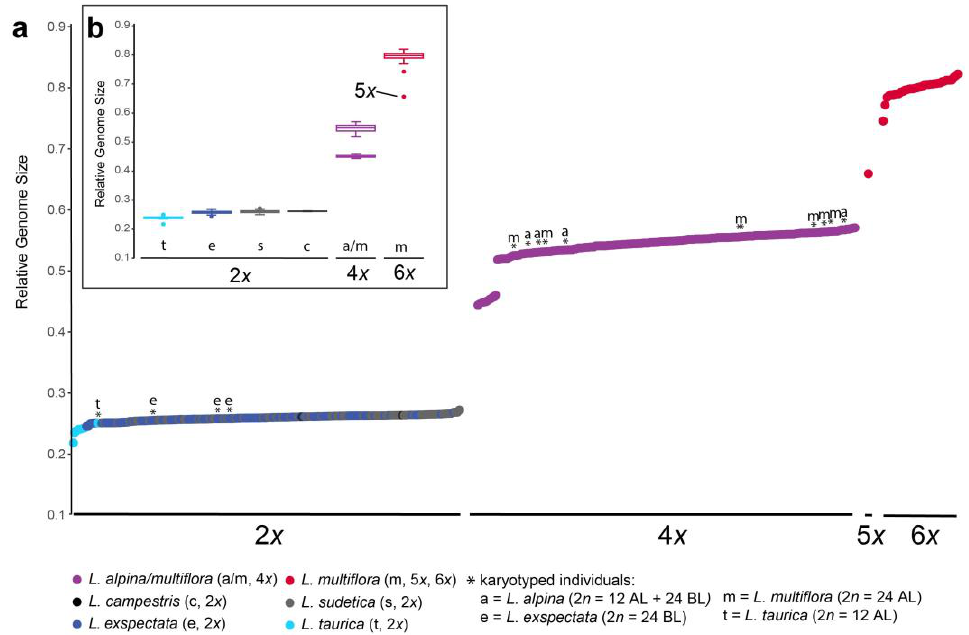
Figure 2. Relative genome size (RGS) of diploid (2 x ) Luzula campestris , L. exspectata , L. sudetica and L. taurica , tetraploid (4 x ) L. alpina and L. multiflora (24 AL), and hexaploid (6 x ) L. multiflora , including one pentaploid (5 x ) individual. ( a ) Scatterplot of all investigated individuals, ordered by increasing RGS; asterisks indicate karyotyped individuals labelled with the first letter of the epithet. ( b ) Box plots of RGS per species.